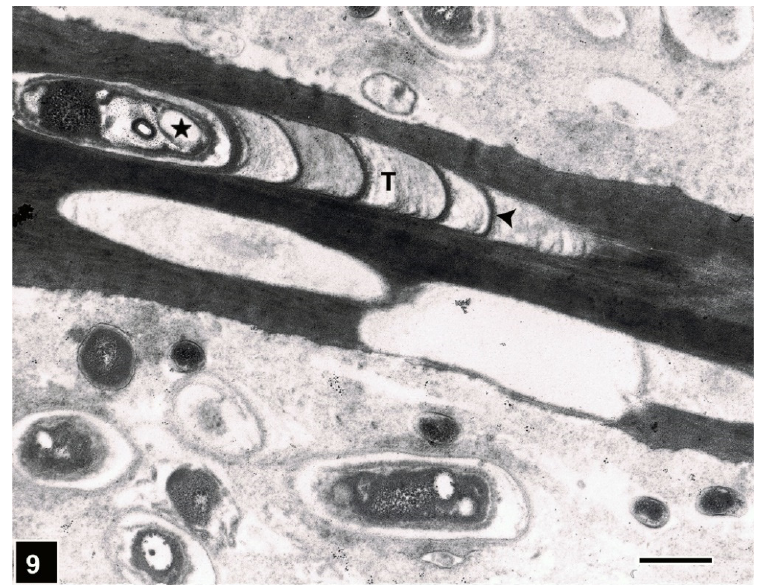
Figure 9. TEM of a transverse section through a Pinus radiata tracheid wall showing the presence of a tunnel (T) containing a bacterium (asterisk) and crescent-shaped periodic slime bands (arrowhead). Scale bar = 2 µm. The image is reproduced from Singh et al. (2019) IAWA J.